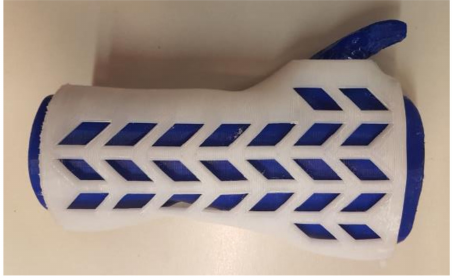
Figure 7. Orthosis on a two-material forearm phantom.